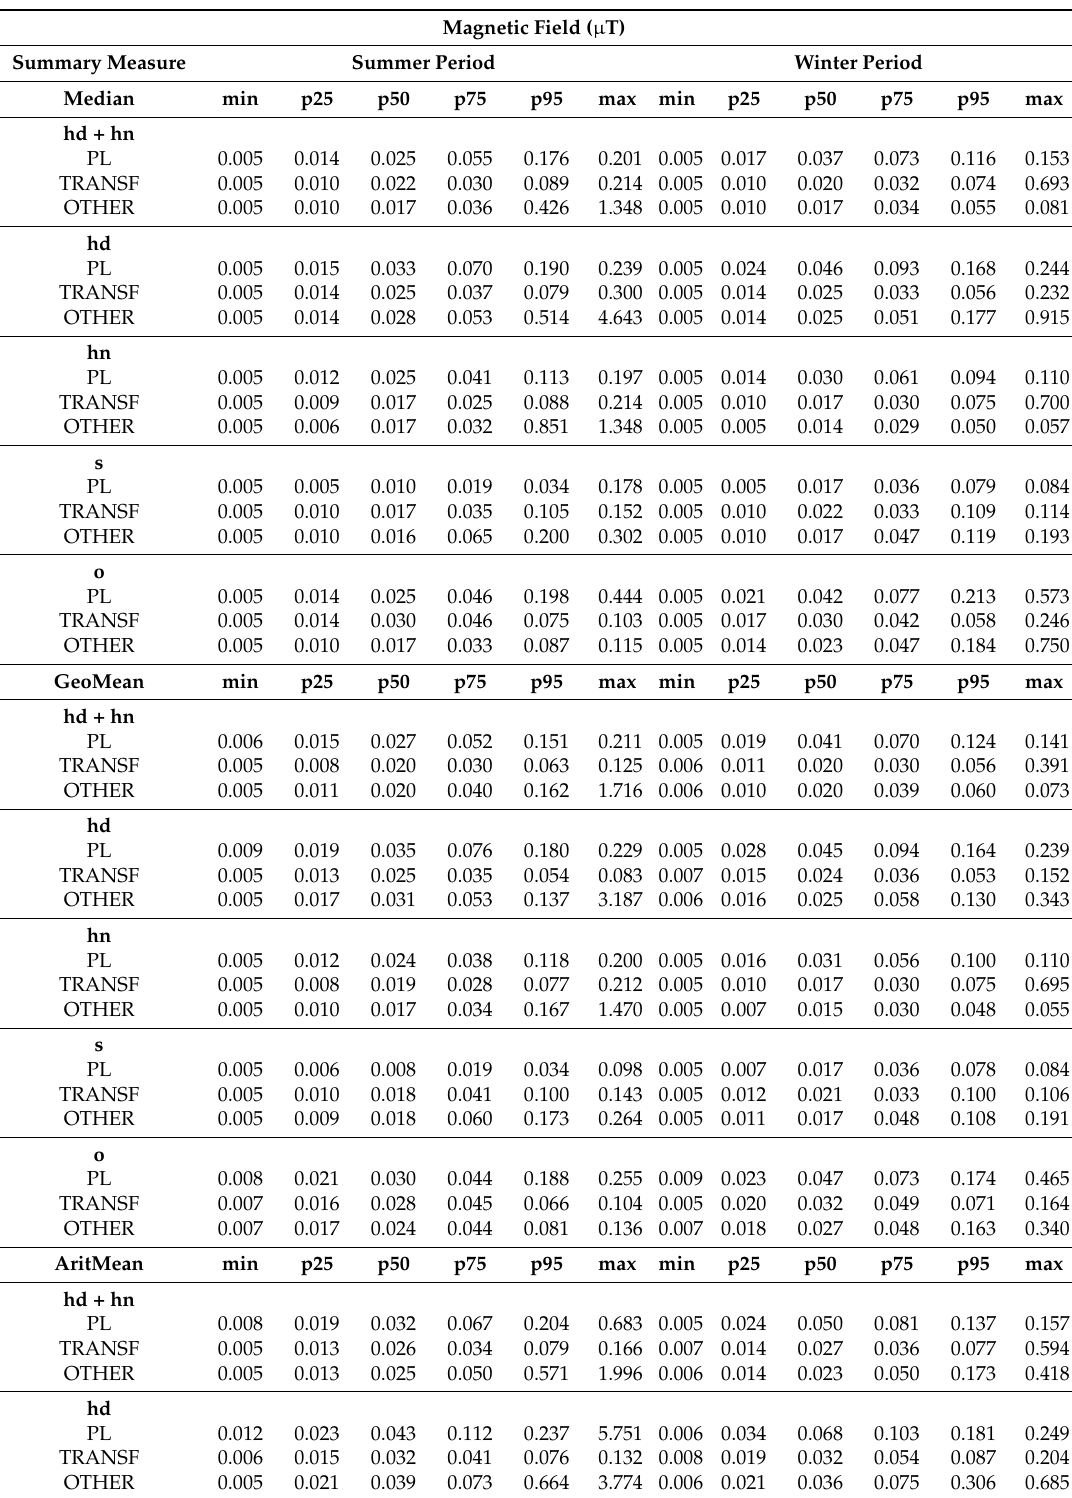
Table A5. Distribution values of median, geometric mean and arithmetic mean of magnetic field ( µ T) in different environments for each personal measurement day for each group and season in the broadband frequency